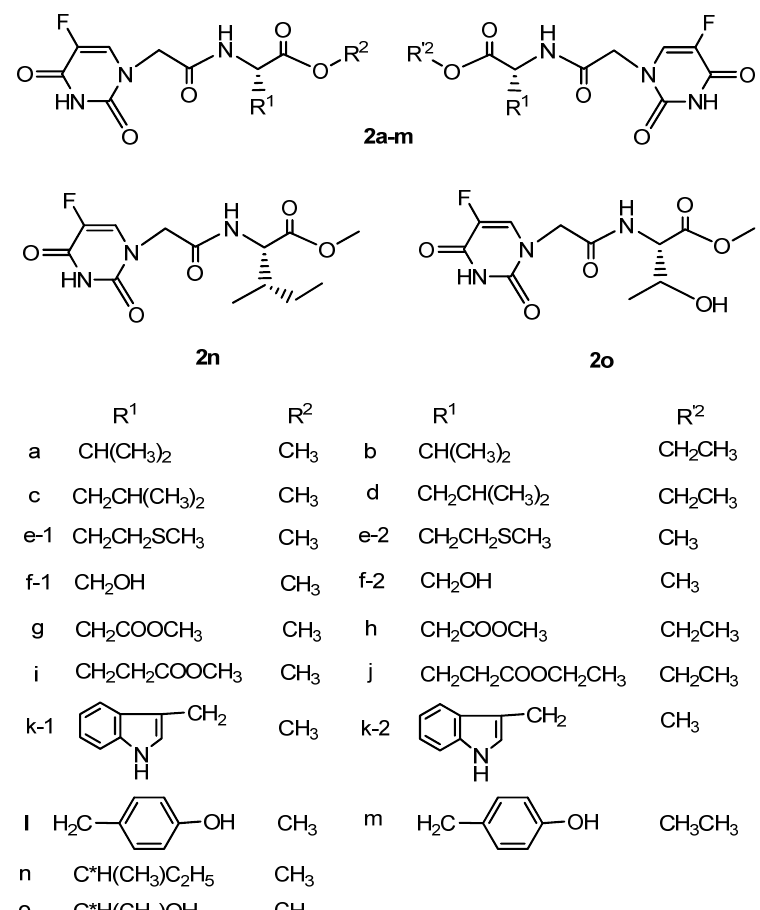
Figure 1. Structural formulae of compounds 2